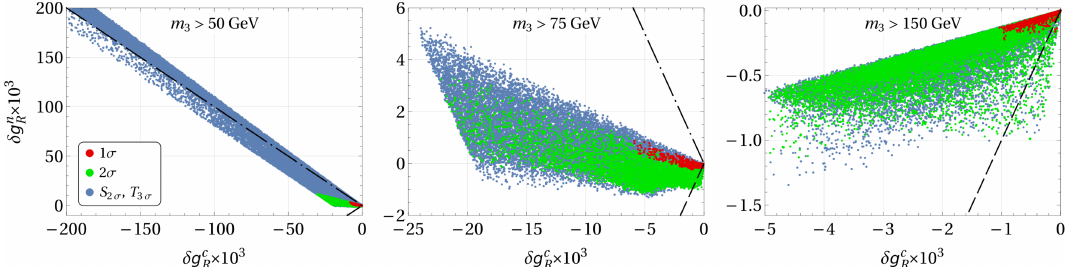
in the aligned 2HDM. The displayed points and the versus δg c R R = − δg c . R R